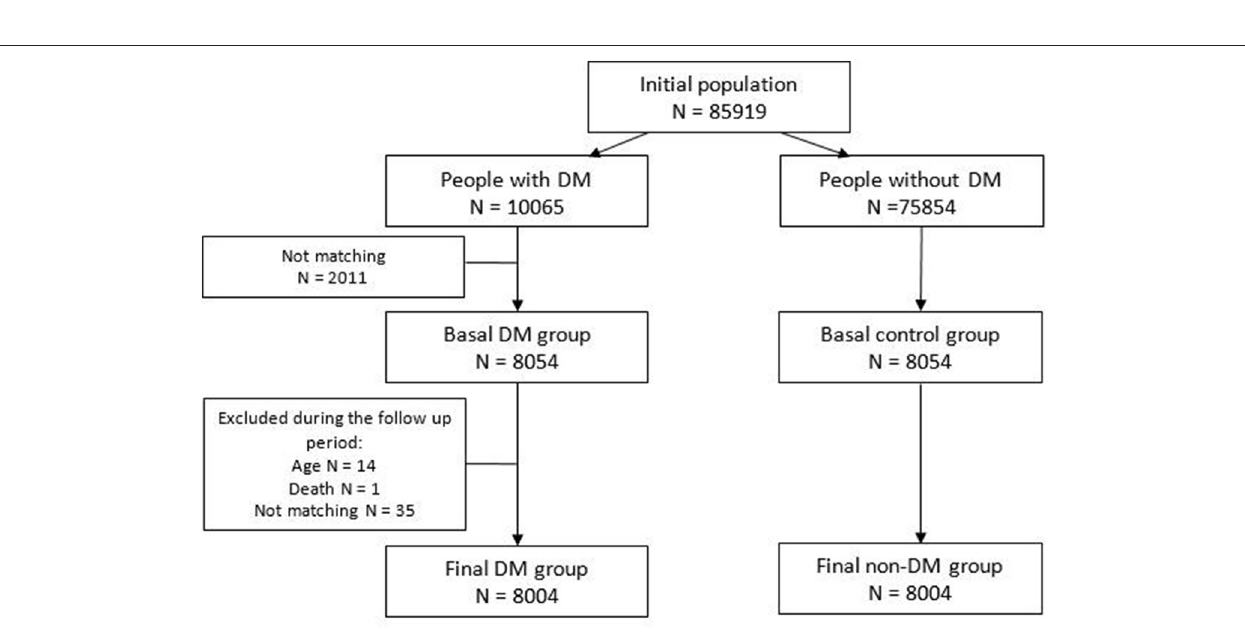
FIGURE 2 | Flow chart of the cohorts within the study population.